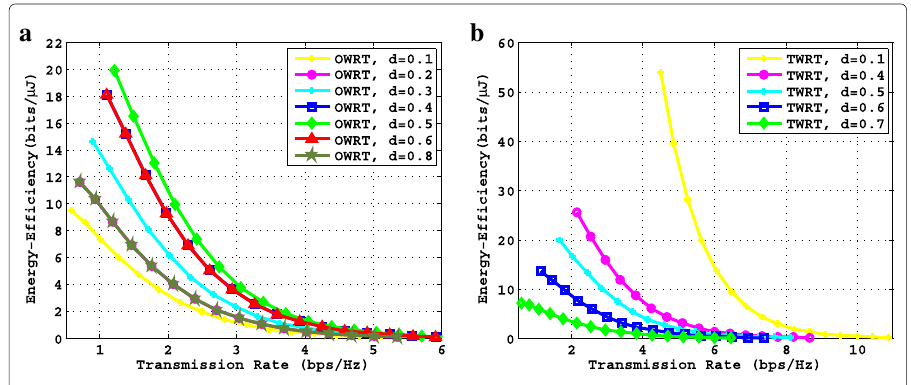
Fig. 4 EEs with different d . a OWRT. b